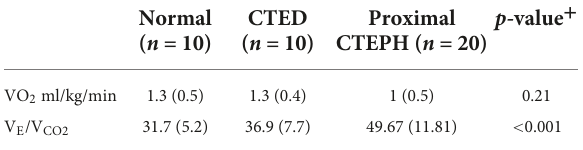
TABLE 5 Baseline cardiopulmonary exercise testing between subgroups of thrombotic pulmonary vascular disease.